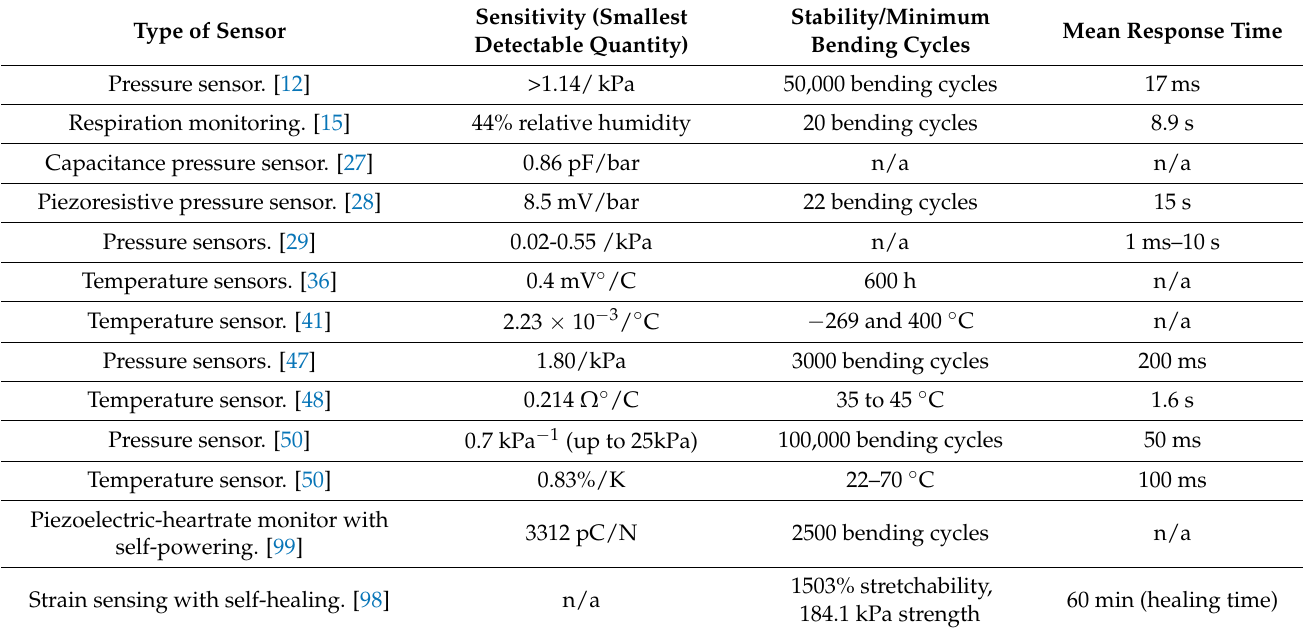
Table 5. Examples of wearables and some key characteristics studied in